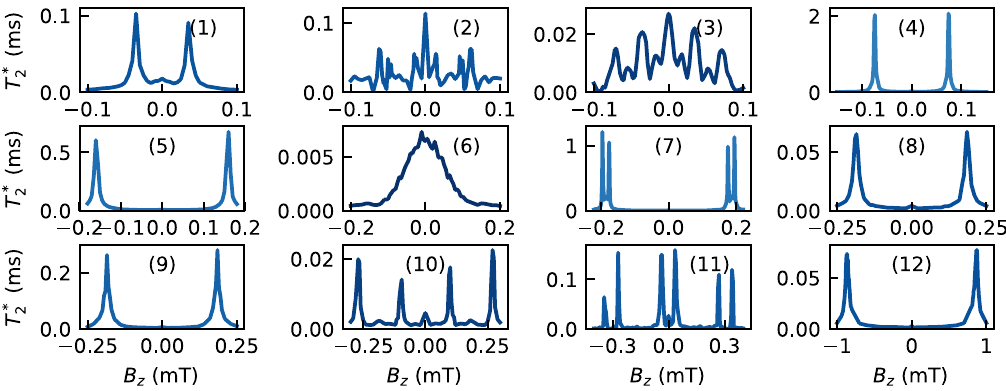
FIG. 16. Coherence time against the magnetic field for the theoretical configurations containing strongly coupled nuclear spins. Numbers (1–12) correspond to different bath configurations with one or several strongly coupled nuclear spins (Table